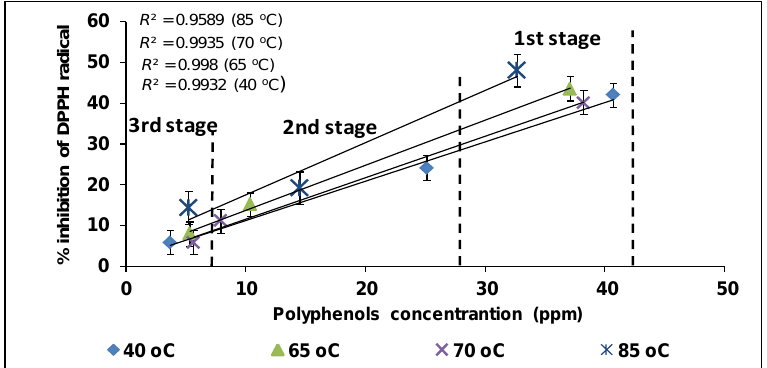
Figure 5. Antioxidant activity of ethanolic extracts of olive leaves. * Sum of the oleuropein, verbascoside, luteolin-7- O -glucoside and apigenin-7- O -glucoside concentrations at the end of each stage of the multistage extraction which had been performed at 40, 65, 70 and 85 °C and dissolved prior to the addition in DPPH (2,2,-diphenyl-2-picryl-hydrazyl) solution. Mean values ( n = 3,